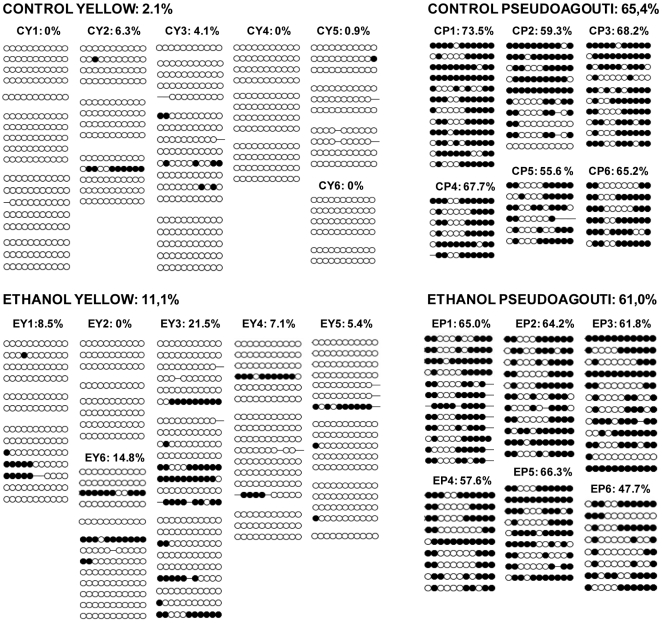

Avy methylation in control offspring and offspring exposed to ethanol in utero.Only mice with 100% yellow and 100% pseudoagouti coats were assayed. Control yellow (CY) offspring are numbered 1–6, control pseudoagouti (CP) offspring are numbered 1–6, ethanol yellow (EY) offspring are numbered 1–6 and ethanol pseudoagouti (EP) offspring are numbered 1–6. Methylation was analyzed by sequencing individual clones of PCR-amplified, bisulfite-converted tail genomic DNA. Each circle represents an individual CpG. Open circles indicate an unmethylated CpG, and closed circles represent a methylated CpG. Each line represents an individual clone and the methylation pattern of one allele in one cell. Each block of lines comprises clones derived from one bisulfite conversion. The total percentage of methylated CpGs is shown above each individual and group. There are more hypermethylated clones in yellow ethanol exposed mice (Pearson's chi-square tests. p<0.01). There is no effect of ethanol exposure on the methylation of Avy in pseudoagouti mice (Student's t-test, p = 0.27).